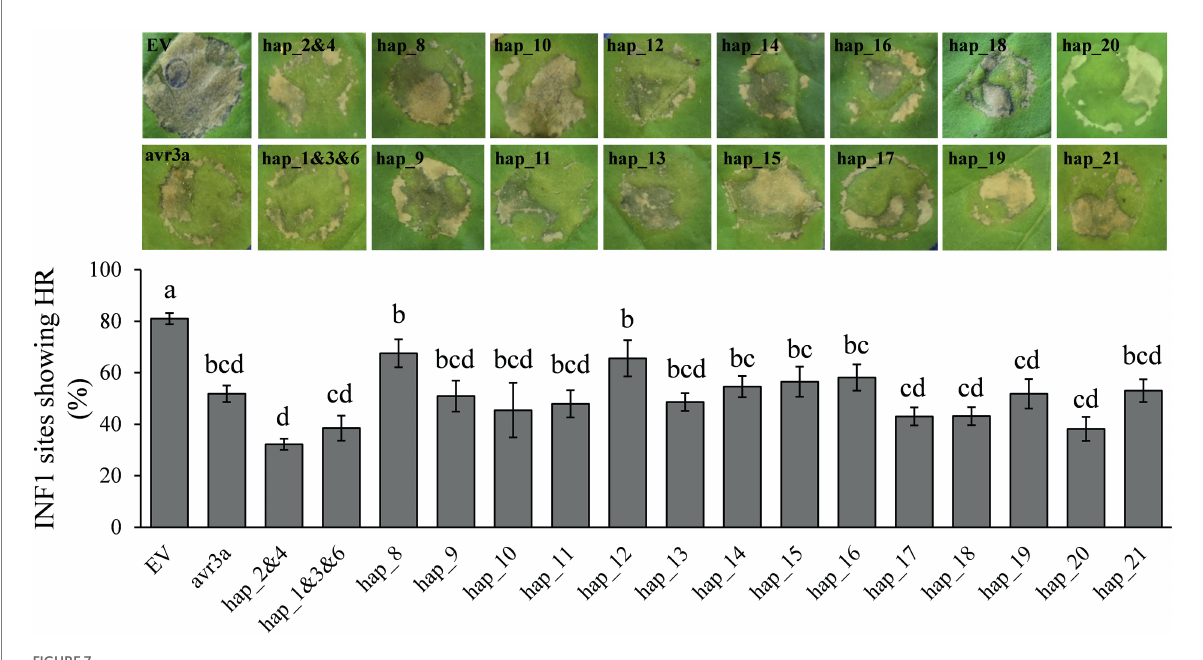
FIGURE 7 Transient overexpression of GFP- Pi02860 haplotypes in N. benthamiana suppresses the HR (hypersensitive response) triggered by the elicitin INF1. Top: images of pathogen expression: Bottom: statistical test. EV and avr3a are negative and positive controls, respectively. Hap_1 to Hap_21 are the codes of 21 haplotypes detected. Hap_2 and 4 are deduced into the same isoform and Hap_1, 3 and 6 are deduced into another the same isoform, thus only one vector was constructed for each of the two haplotype groups. Results shown are derived from the mean of at least three independent biological replicates.